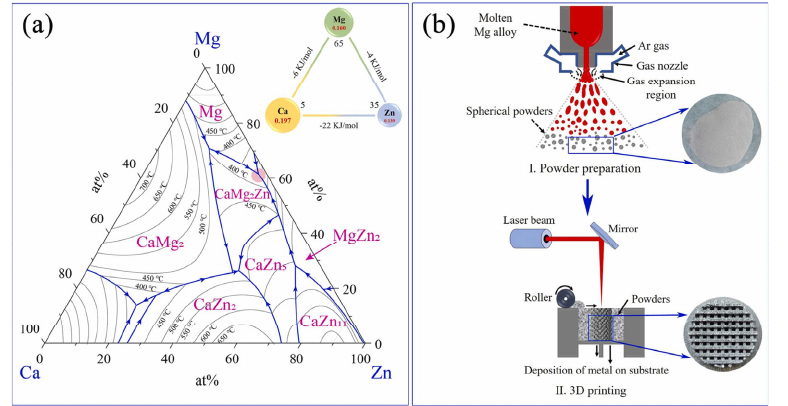
Figure 2. The compositions of the alloy selected in the present investigation are shown in ( a ) sche- matic diagram ( b ) of powder preparation and LPBF [29]. Reprinted with permission from ref. [29]. Copyright 2022 Elsevier.